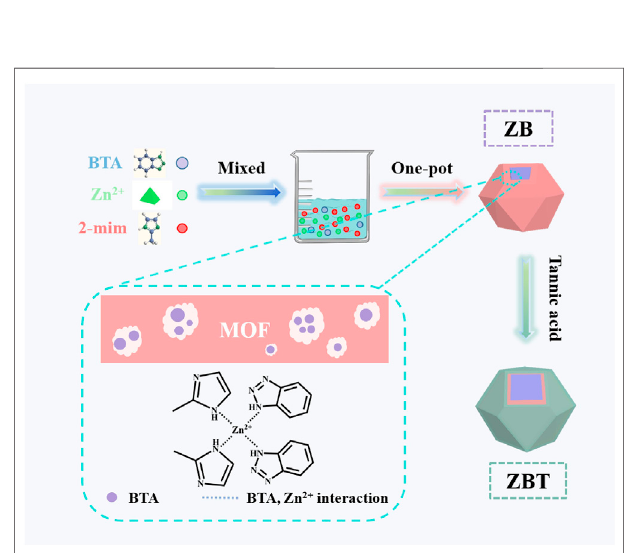
FIGURE 13 | Schematic illustration of the procedure for the synthesis of ZBT nanomaterials (Yang et al., 2021).